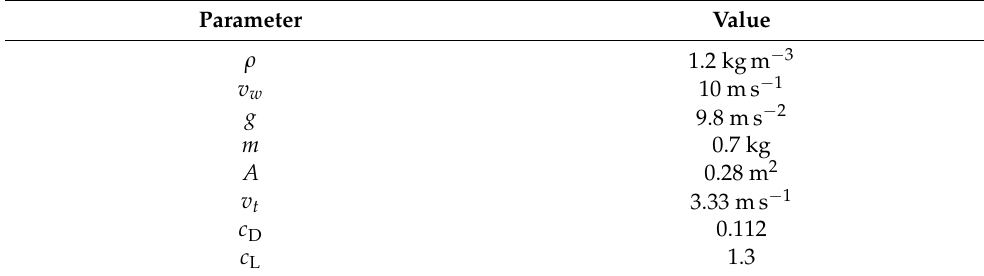
Table 1. Simulation